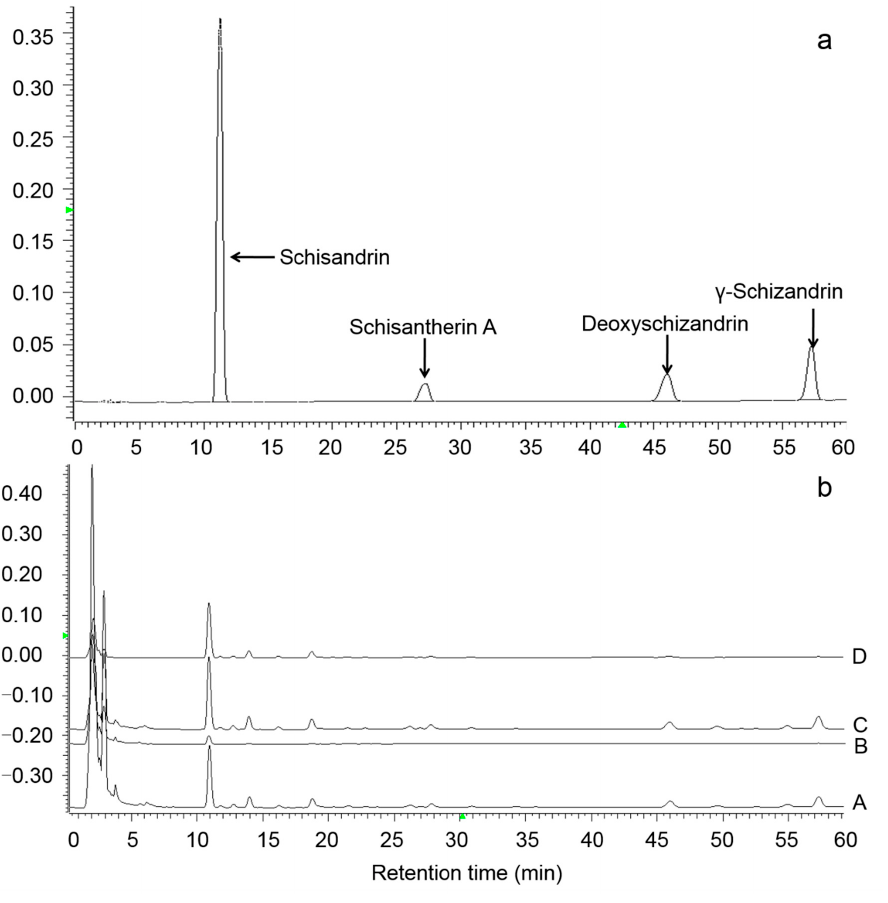
Figure 1. HPLC chromatograms of four lignan standard compounds ( a ) and the four S. chinensis extract samples A, B, C (diluted five times), and D (diluted five times) ( b